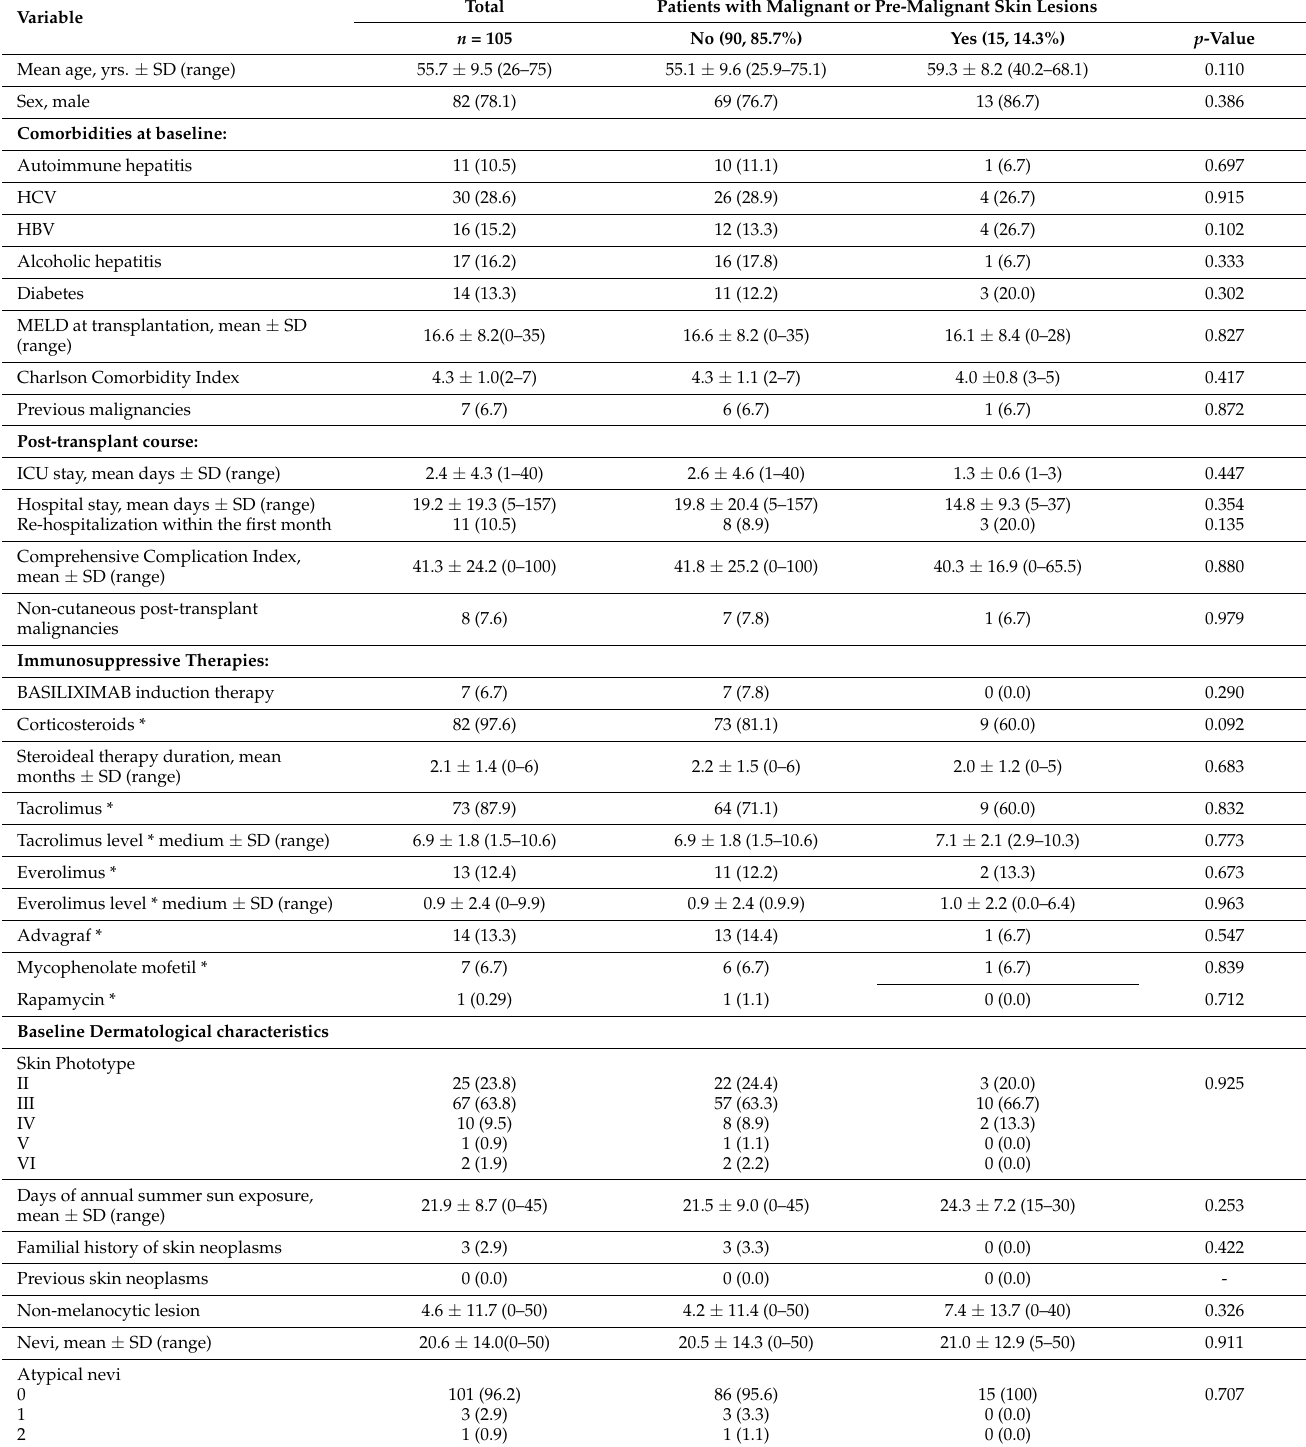
Table 1. Patient demographics and clinical data. Data are expressed as absolute numbers and percentages ( n (%)), unless otherwise